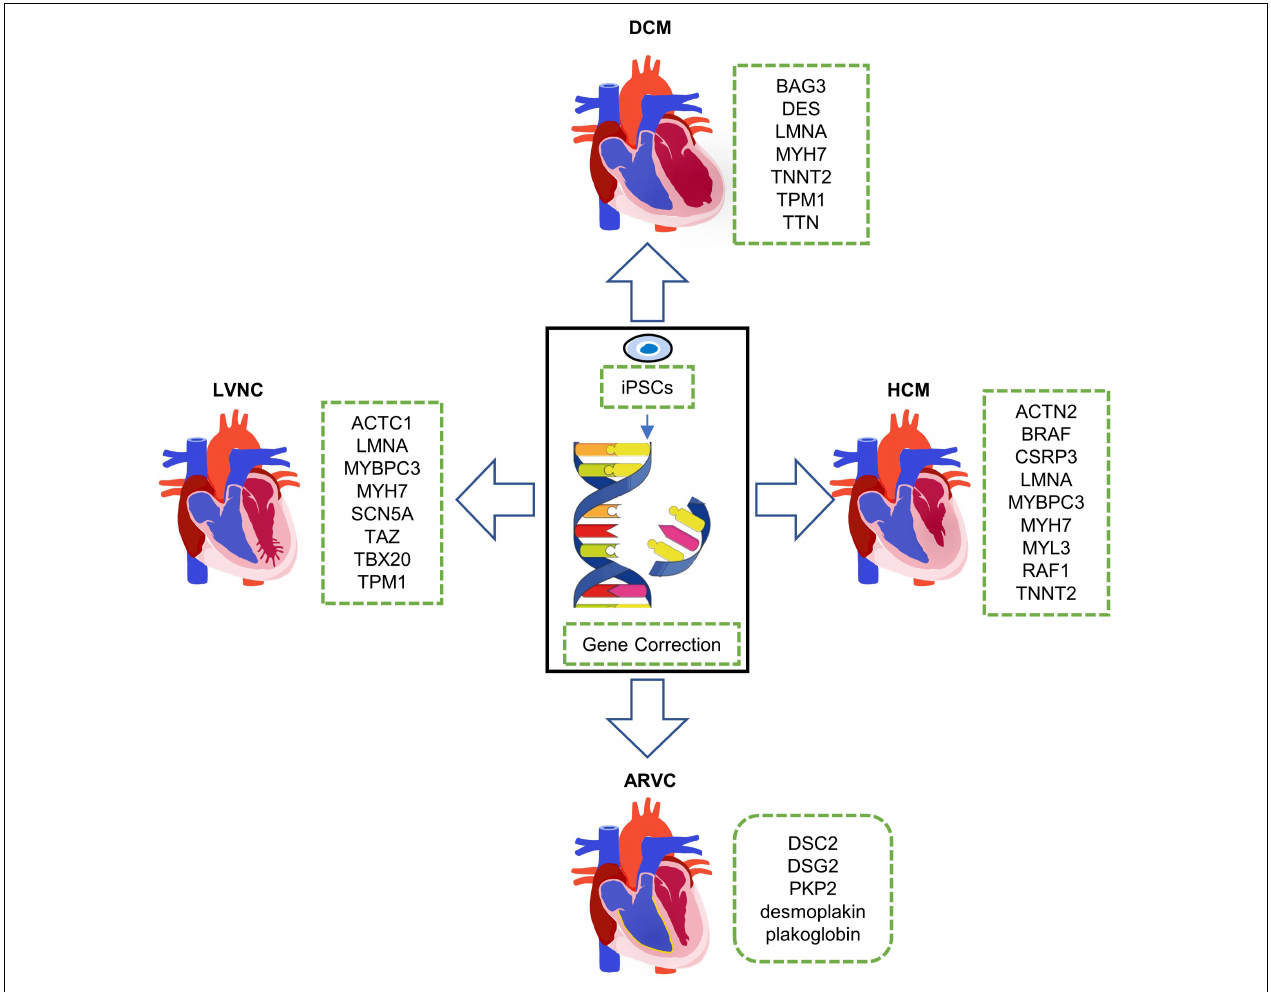
FIGURE 1 | Clinical phenotypes of inherited cardiomyopathies and disease modeling with human induced pluripotent stem cells (hiPSCs). DCM, dilated cardiomyopathy; HCM, hypertrophic cardiomyopathy; ARVC, arrhythmogenic right ventricular; and LVNC, left ventricular